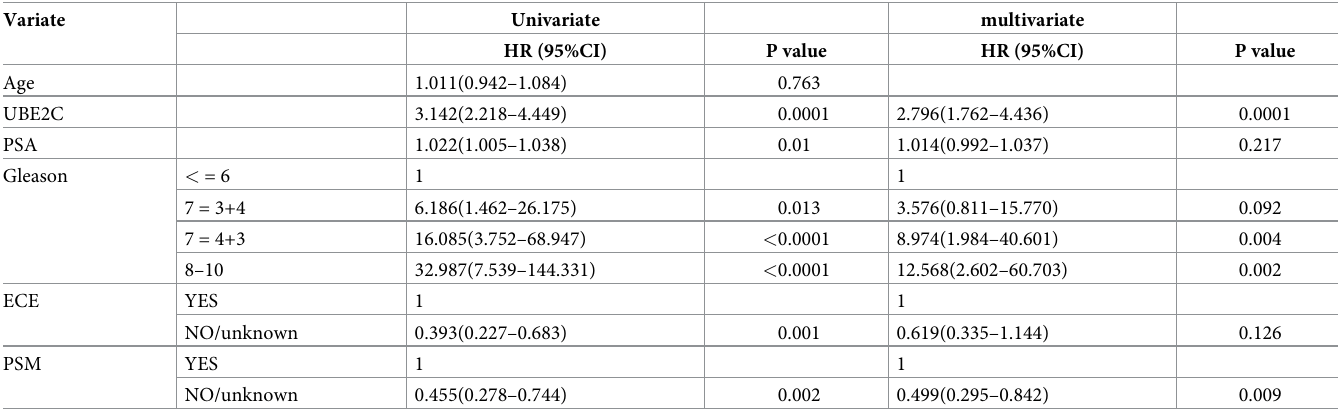
Table 3. Univariate and multivariate Cox regression analysis for prostate cancer relapse-free survival.